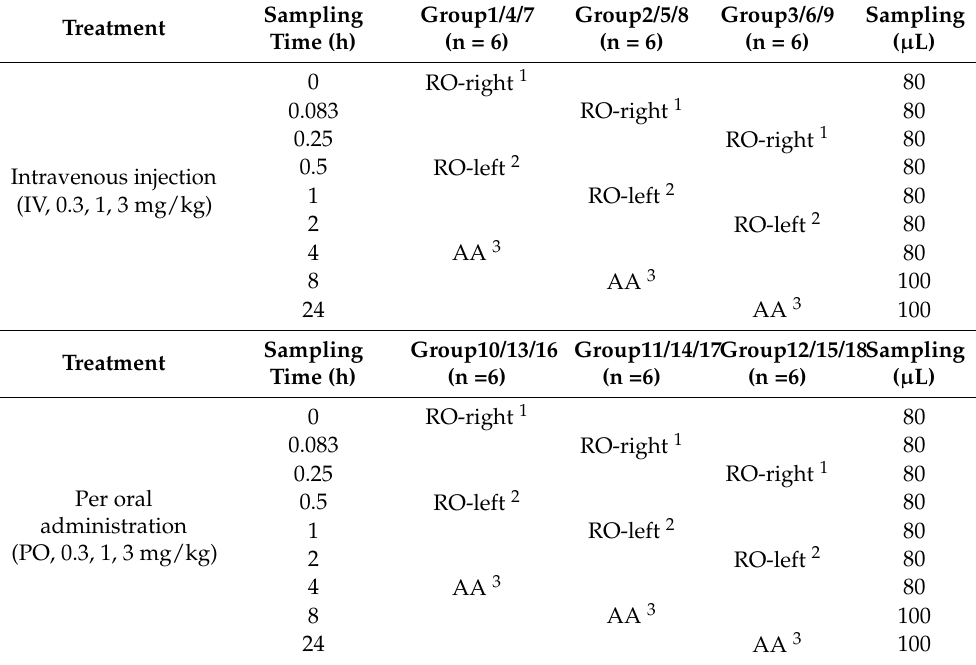
Table 1. Blood sampling procedure in mice.